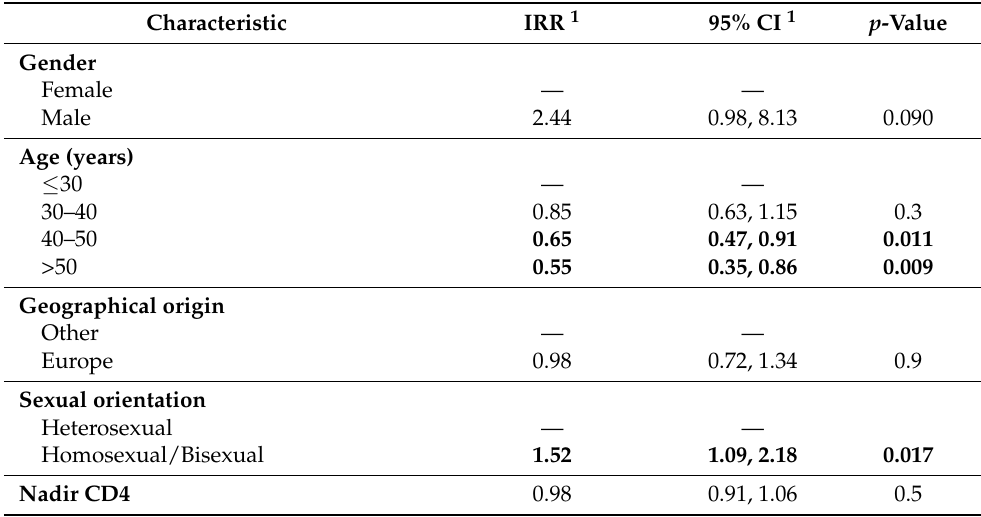
Table 3. Generalised linear model to assess factors associated with the number of syphilis reinfections among